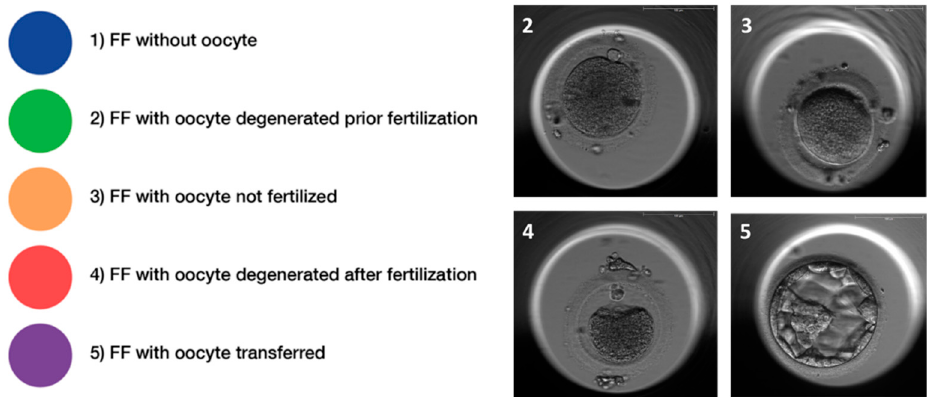
Figure 2. Classification of follicular fluid samples. Follicular fluids (FF) were retrospectively classified according to morphological characteristics of the oocyte and/or embryo and classified into five distinctive quality classes, i.e., (1) FF without an oocyte, (2) FF with an oocyte, which degenerated prior to fertilization, (3) FF with an oocyte that could not be fertilized, (4) FF with an oocyte, which degenerated after fertilization, and (5) FF with a successfully fertilized oocyte and transferred or frozen embryo. Representative pictures of oocytes (class 2–4) and a blastocyst (class 5), respectively, are provided in the panel to the left.